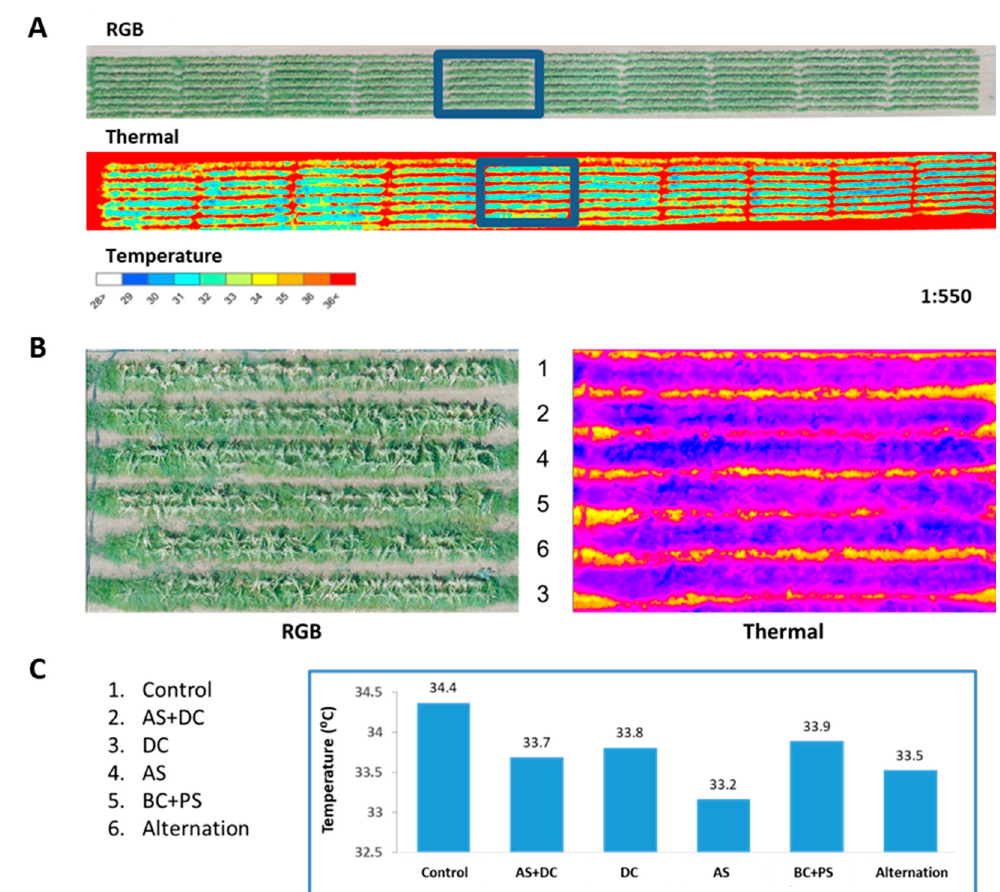
Figure 7. Aerial photograph and thermal analysis sample (Amir, summer 2018). The field was photographed by a quadcopter equipped with an RGB and infra-red sensitive thermal camera 63 DAS (8 DAF). A . Aerial overview of the whole field using both cameras, with a scaling ratio of 1:550. The blue rectangles depict block 5. B . Close-up of block 5 (from the 10 blocks or repeats) of this experiment. In the RGB aerial photo (left), the AS treatment has a greenish appearance of the canopy with no yellow-brown patches, while the control treatment is seen as yellowish. In the remote aerial imaging of the thermal infra-red crop canopy (right), the temperature difference is observed as a dark-blue (colder temperature) appearance of the AS-treated lines, while the non-protected control lines have a higher temperature represented by a reddish-pink color. C . Analyzing block 5 canopy temperature variations among the treatments. Each bar represents one repeat.